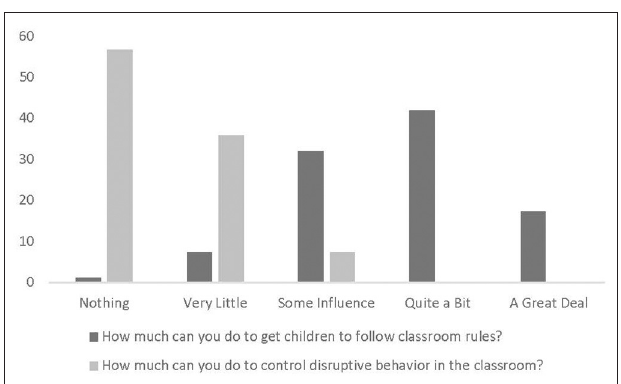
FIGURE 4 | Teacher’s disciplinary self-efficacy (% frequency of